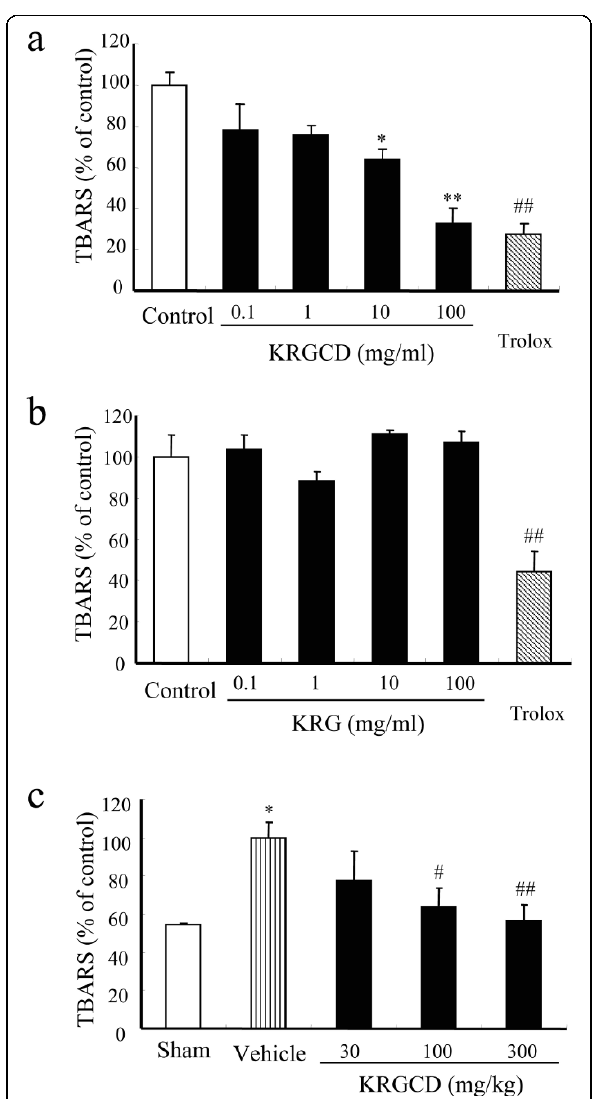
Figure 5 Effect of KRGCD on lipid peroxidation . Effects of KRGCD (a) and KRG (b) on TBARS content in in vitro mouse stomach homogenates. n = 4 for each group. Each value represents the mean ± SEM. * p < 0.05, ** p < 0.01 vs. control, Dunnett ’ s multiple-range test. ## p < 0.01 vs. control, Student ’ s t -test. Effect of KRGCD (c) on TBARS content in mice on HCl/ethanol-induced gastric damage. Sham (n = 3), control (n = 10), 30 mg/kg of KRGCD (n = 6), 100 mg/kg of KRGCD (n = 8), and 300 mg/kg of KRGCD (n = 8). * p < 0.05, vs. sham treated group, Student ’ s t -test. # p < 0.05, ## p < 0.01 vs. control, Dunnett ’ s multiple-range